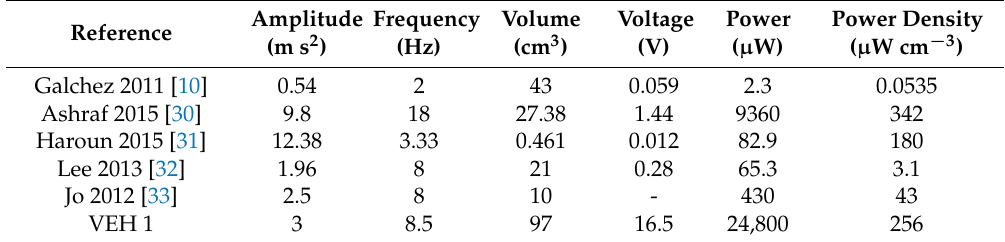
Table 3. Comparison between some reported electromagnetic vibrational energy harvesters (EMVEHs) and this work.